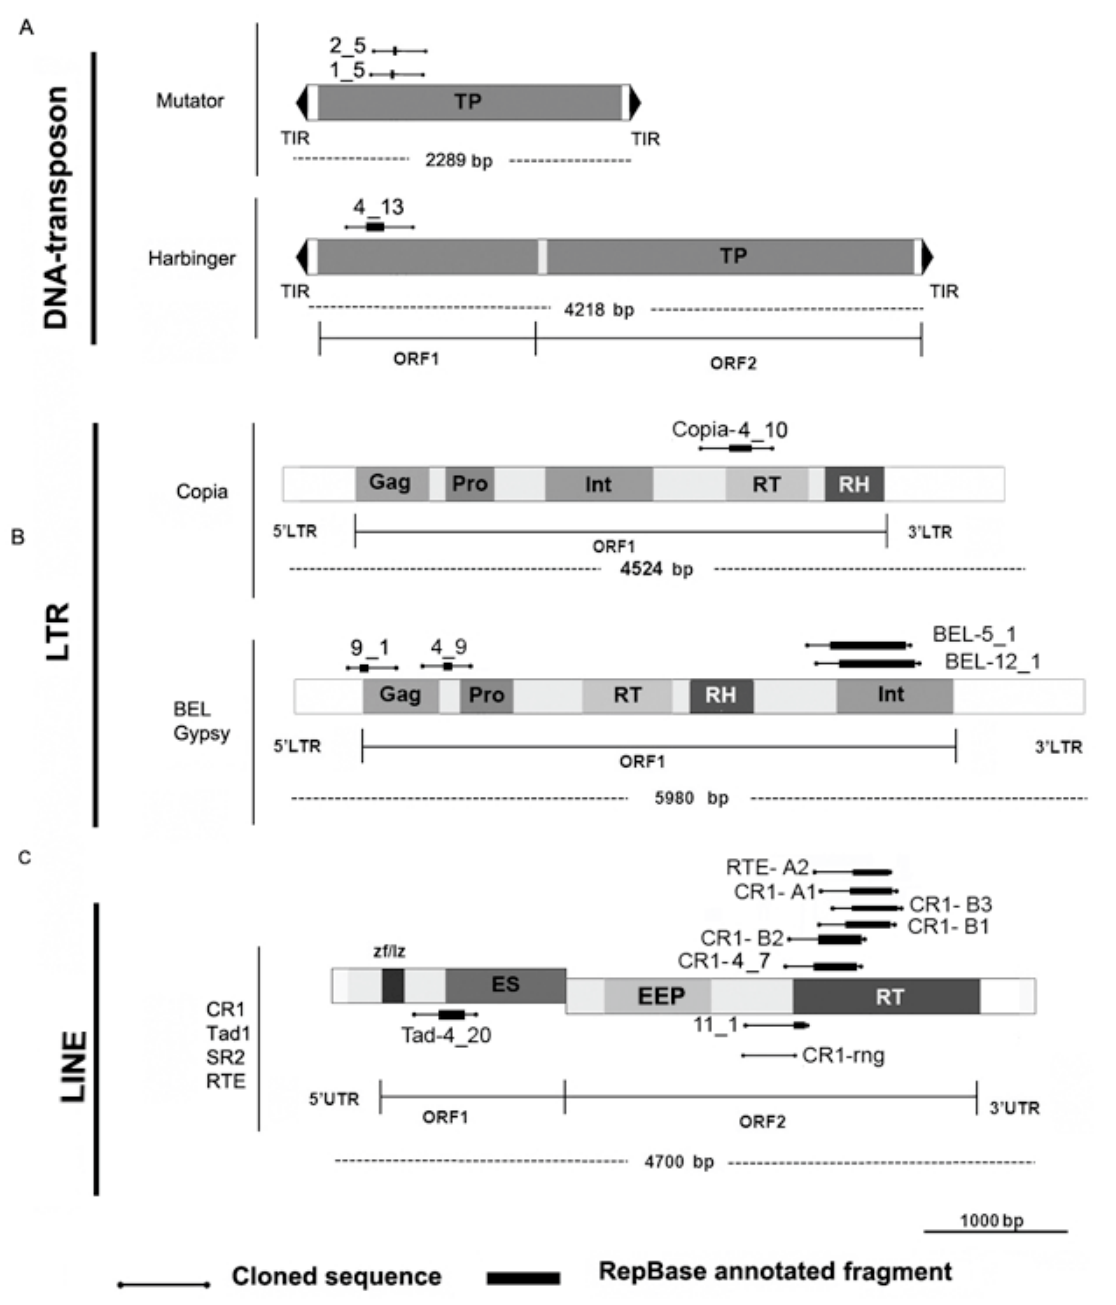
Figure 3. Cloned fragments aligned to TE consensus sequences. A , B and C show transposon types, to which the cloned fragments belong. Element size, 5 ′ - and 3 ′ -untranslated regions (UTRs), terminal inverted repeats (TIRs), long terminal repeats (LTRs), and open reading frames (ORFs) are shown. Encoded predicted proteins: zf/lz domains—“zinc fingers” and “leucine zipper”; ES—esterase, EEP—exonuclease/endonuclease/phosphatase; RT—reverse transcriptase; RH— RNAseH; Int—integrase; Gag—DNA-binding protein; Pro—proteinase; TP—transposase. TE schemes were constructed according to [58], with modifications. The similarity of each RepBase hit is reported in Table S1.